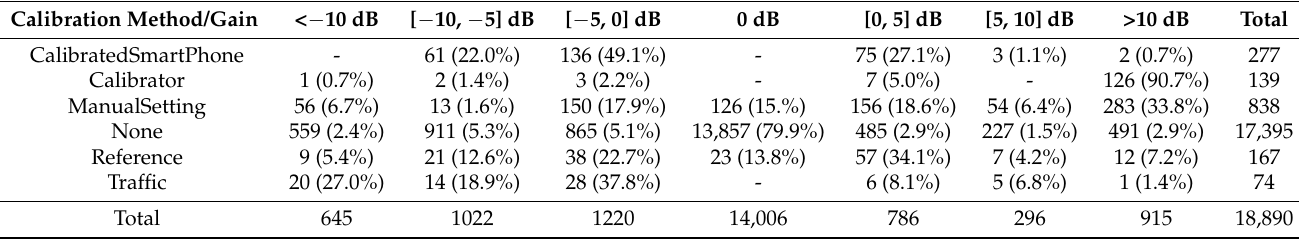
Table 16. Cross table of the number of collected tracks in function of the calibration method and the calibration gain (data from release 49).